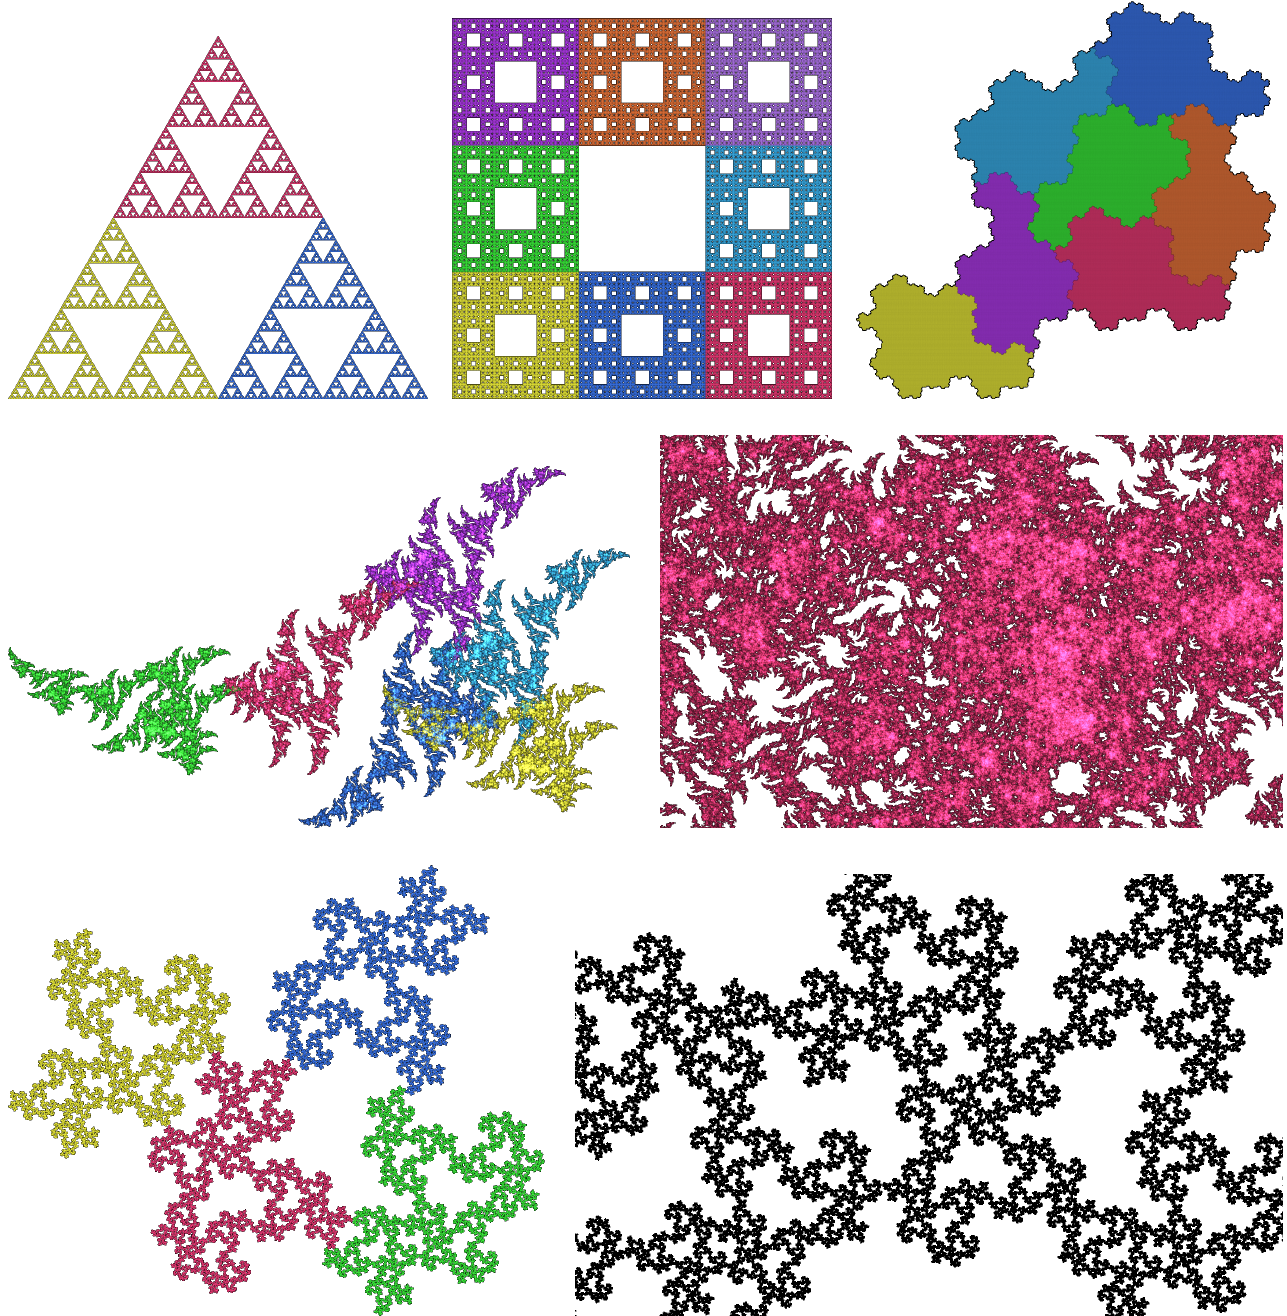
Figure 1. ( Top ): Sierpi´nski triangle, Sierpi´nski carpet and a variation of Gosper’s snowflake tile are classical shapes with a simple open set. ( Middle ): an example with crystallographic data and high complexity. The six pieces have considerable overlap and OSC is still true. Several magnifications are necessary to reveal the local structure. ( Bottom ): a carpet with low complexity generated from an irrational rotation. There are no characteristic directions. See Section